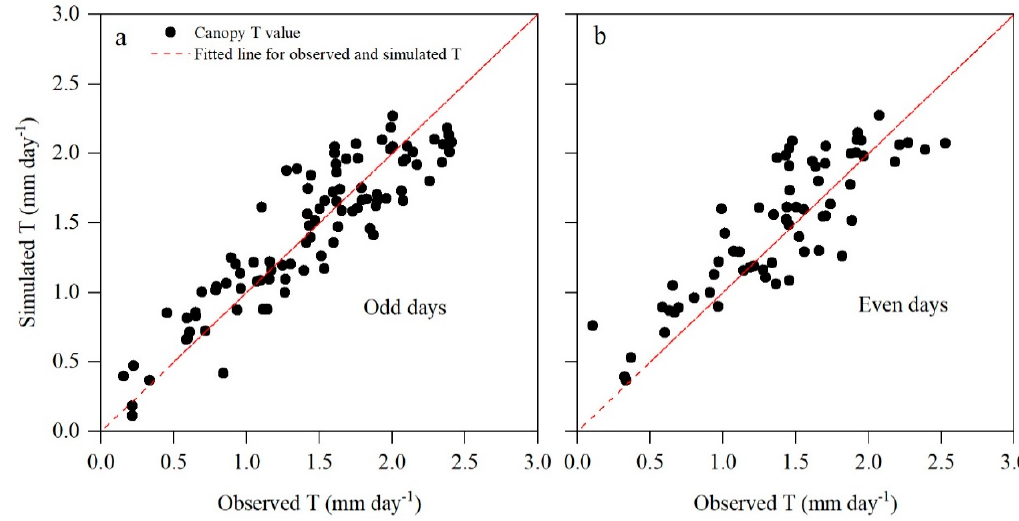
Figure 5. Comparison of the observed and simulated T during the calibration (odd days in 2017 and 2021, ( a )) and validation (even days in 2017 and 2021, ( b )) phases.